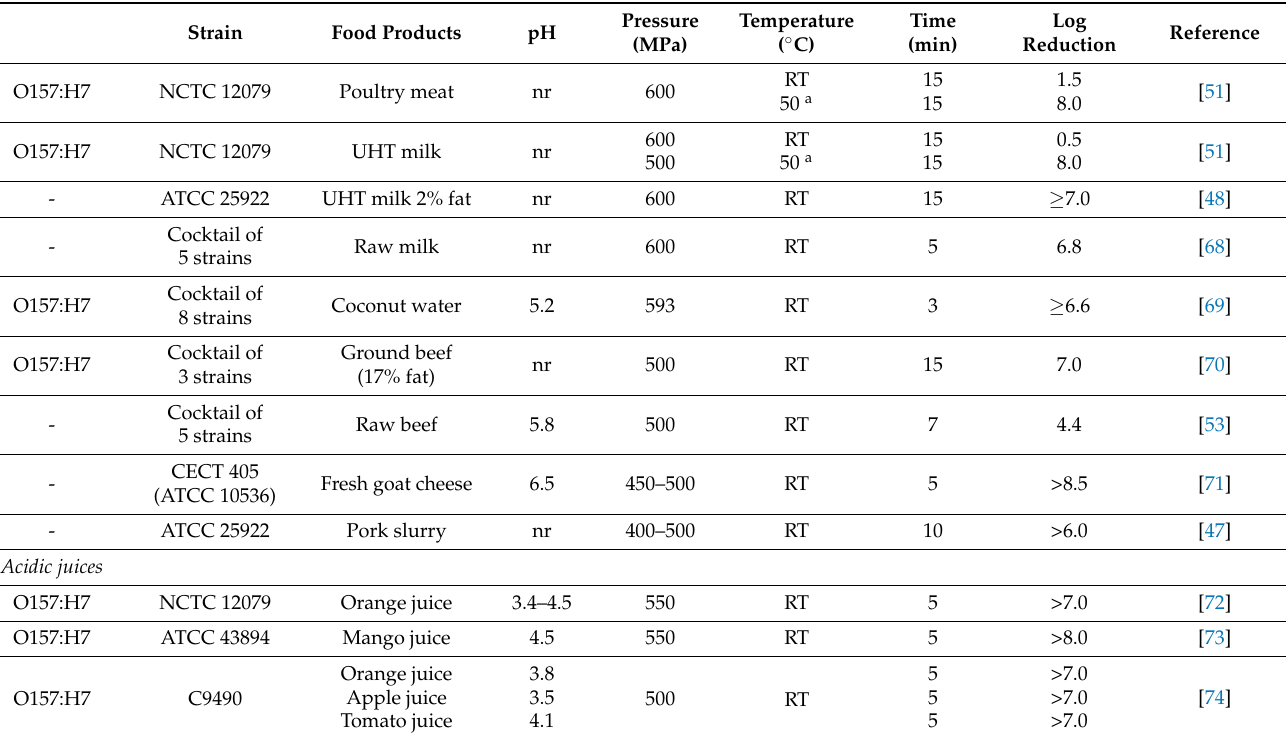
Table 2. Inactivation of Escherichia coli in milk, meat products, coconut water, and acidic fruit juices by high-pressure processing (HPP)